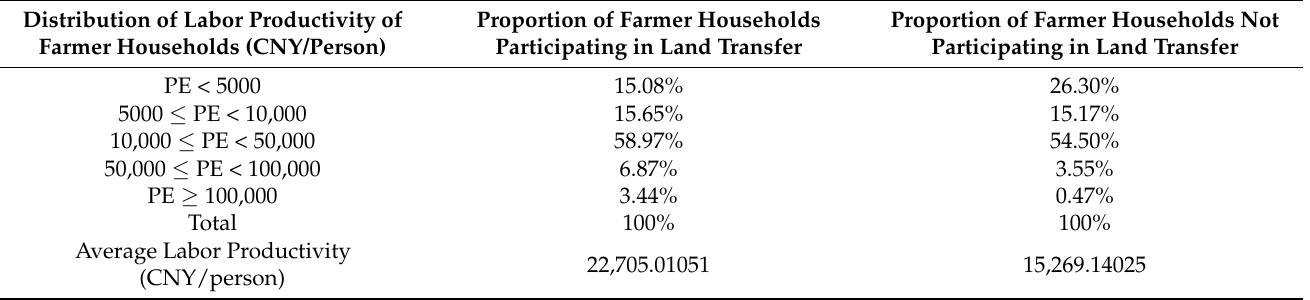
Table 3. Distribution of Farmer Households Participating in Land Transfer and Their Labor Productivity.